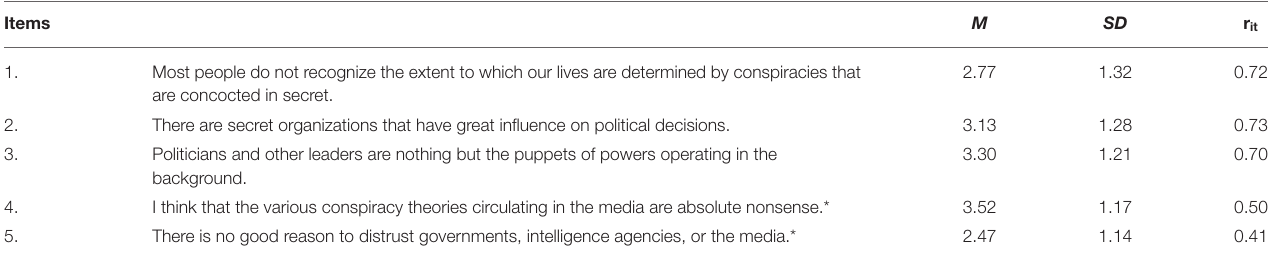
TABLE 1 | Descriptive item statistics for the conspiracy mentality